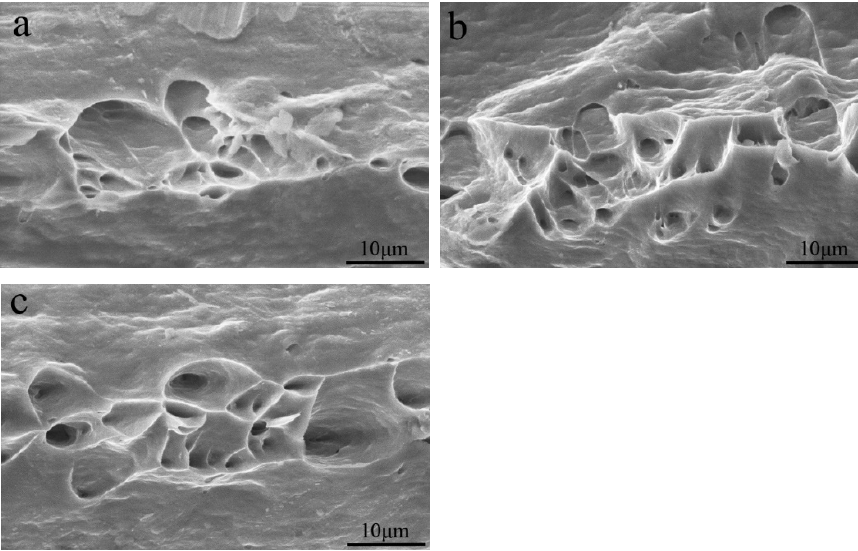
Figure 7. Tensile fracture morphology of the heat-treated foil alloys tested at 50 °C: ( a ) Al-0.2Fe- 0.06Cu; ( b ) Al-0.2Fe-0.06Cu-0.1La; ( c ) Al-0.2Fe-0.06Cu-0.15La.